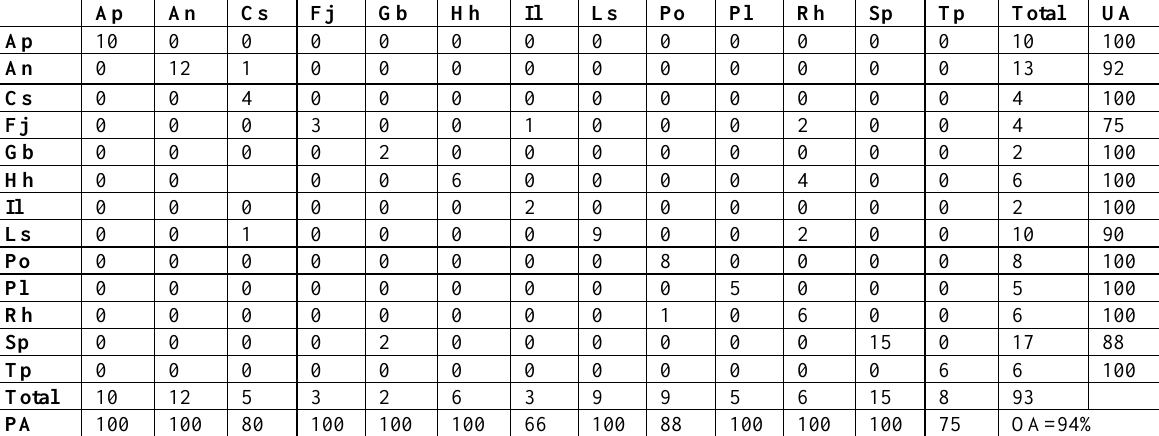
Table 4:Confusion Matrix of Artificial Neural Network